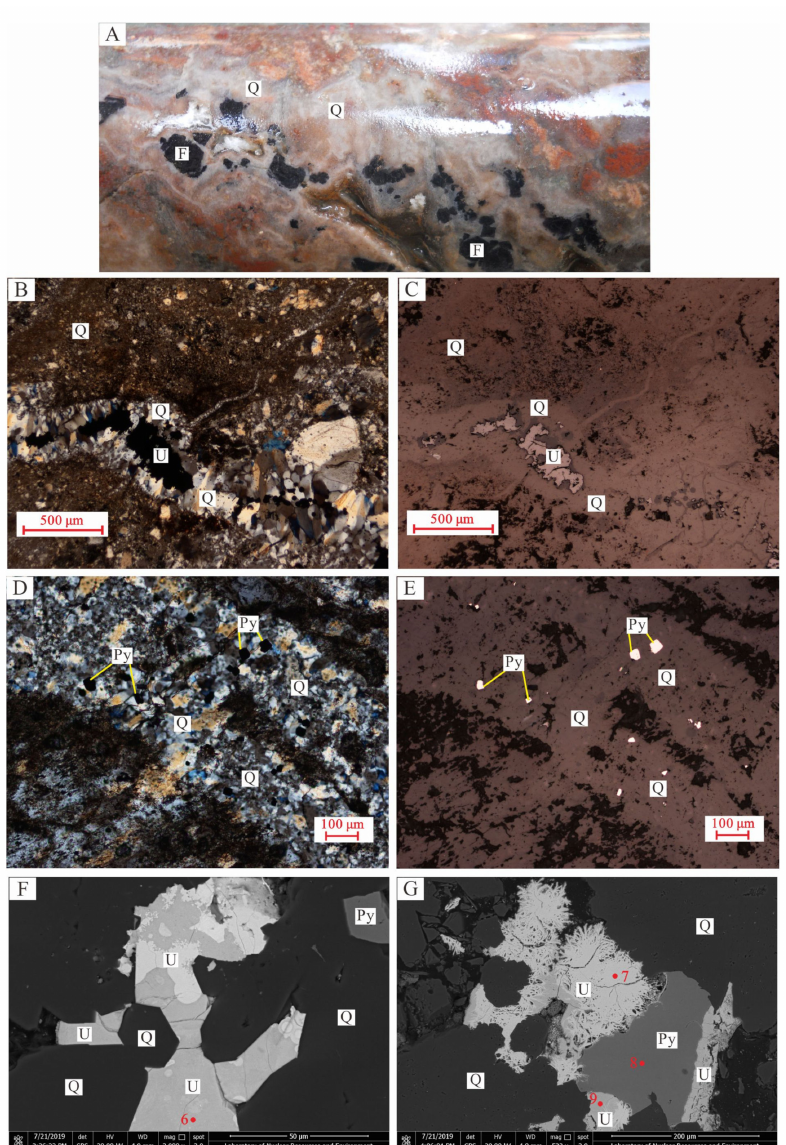
Figure 5. Veined uranium ore with microcrystalline quartz as the main gangue mineral. ( A ): Microcrystalline quartz and fluorite were filled between reddish clastic grains. ( B , C ): Pitchblende (U) occurs in the middle of the microcrystalline comb-like quartz (Q) vein. ( D , E ): Pyrite (Py) with a good crystal morphology embedded between quartz (Q) crystals. ( F , G ): Pitchblende (U) and pyrite (Py) are embedded in microcrystalline quartz (Q), and the boundaries between pitchblende, pyrite, and quartz crystals are clear and straight. ( B ): 5 × , Cross-polarized light; ( C ): 5 × , Reflected-light; ( D ): 20 × , Cross- polarized light; ( E ): 20x, Reflected-light; ( F , G ): SEM images. ( A , B , C , F ) Sample No. M17-82, and ( D , E , G ) sample No. M17-88. Graph surface digital representation energy-dispersive spectrum measuring point